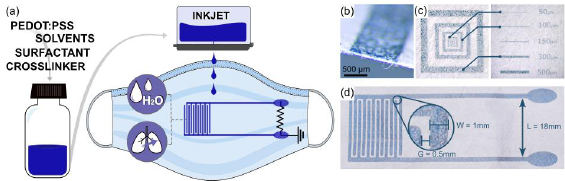
Figure 1. E-mask fabrication process. ( a ) Schematics of the e-mask fabrication route composed of the printable PEDOT:PSS ink formulation (on the left), the sensor direct printing onto the medical facemask (on the right), and the possibility of dual monitoring with IDEs. ( b ) Picture of a printed IDEs finger, a cross-section view. ( c ) Optical images of the square resolution pattern printed on the facemask filter fabric with a zoomed view of the printed lines with different width. ( d ) Picture of the printed IDEs sensor with the specific dimensions: the length between the electrodes (L), the width of the electrodes’ fingers (W), and the gap between fingers